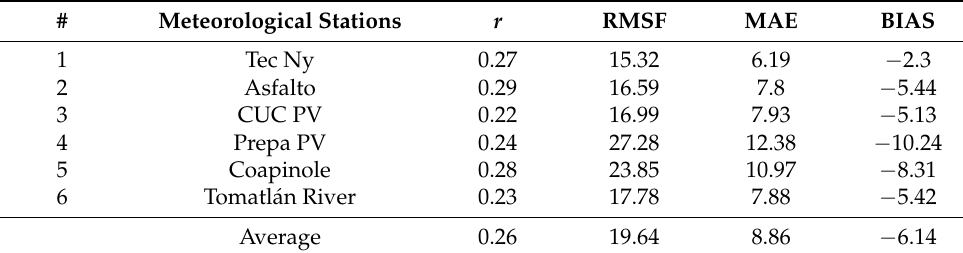
Table 9. Results of the statistical parameters of forecasted and observed precipitation accumulated during the period of 10 June–31 October 2010. The first column shows the six meteorological stations (see Figure 1), and the rest of the columns show the statistical results. RMSF, MAE, and BIAS are in millimeters, while [ − 1 ≤ r ≤ 1 ]